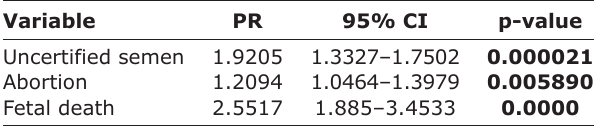
Table-5: Analysis of reproductive variables as possible risk factors associated with IBR infections. Results are shown as PR and 95%